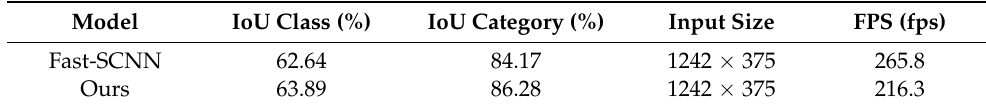
Table 2. Comparing the performance of our proposed improved Fast-SCNN network and the original network on the KITTI semantic segmentation test set.